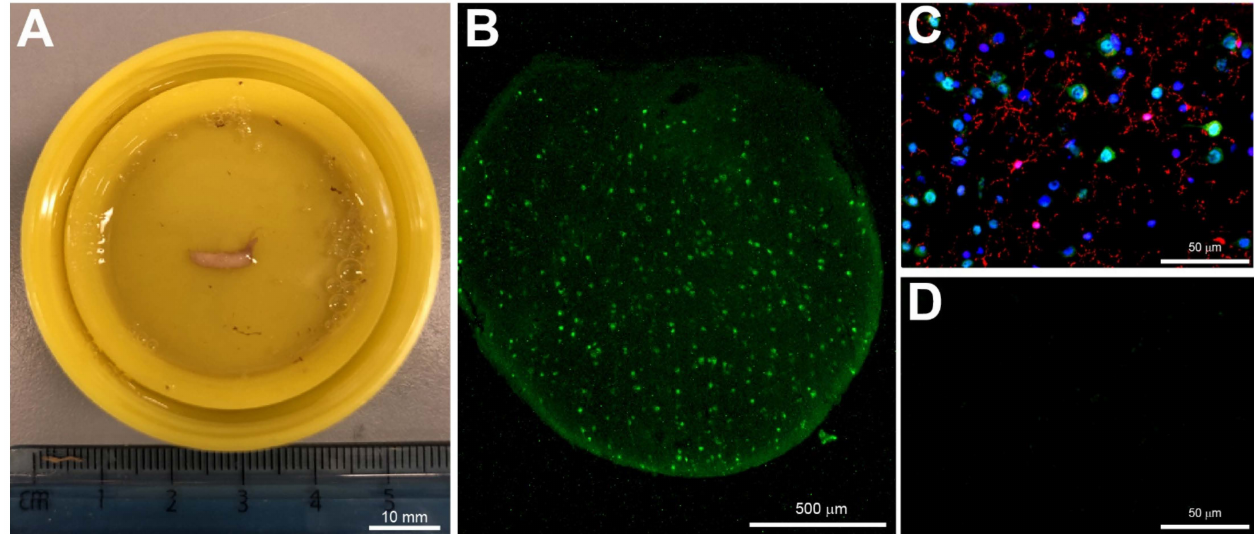
Figure 1. Cerebral biopsy sample and fluorescent immunostaining. ( A ) An image of the cerebral biopsy obtained from a severe TBI patient and fixed in 10% formalin. ( B ) A cross-section of the biopsy stained with the neuronal marker NeuN (green, × 4 magnification). ( C ) Biopsy stained with NeuN (green), Iba1 (red) and Hoechst (blue) ( × 40 magnification). ( D ) Negative control of immunostaining with the primary antibody omitted. Scale bars: ( A ), 10 mm; ( B ), 500 µ m and ( C , D ) 50 µ